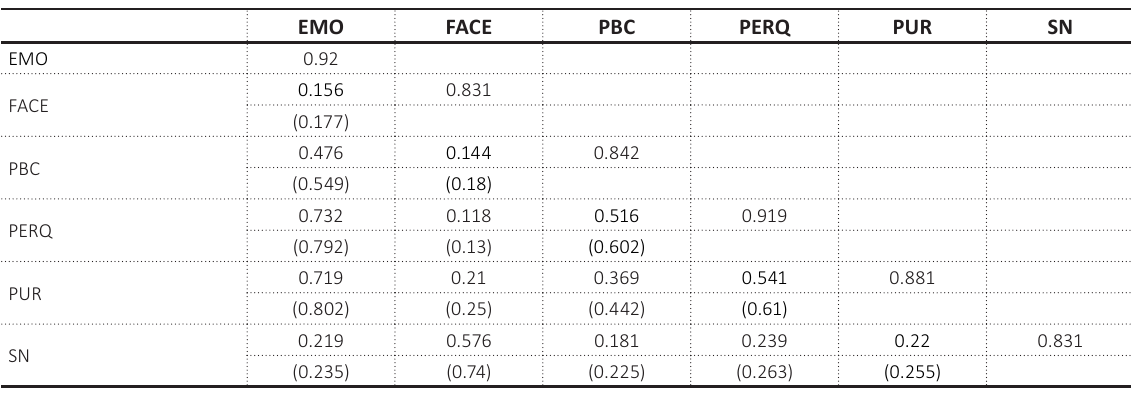
Table 2. Fornell-Larcker and HTMT criteria